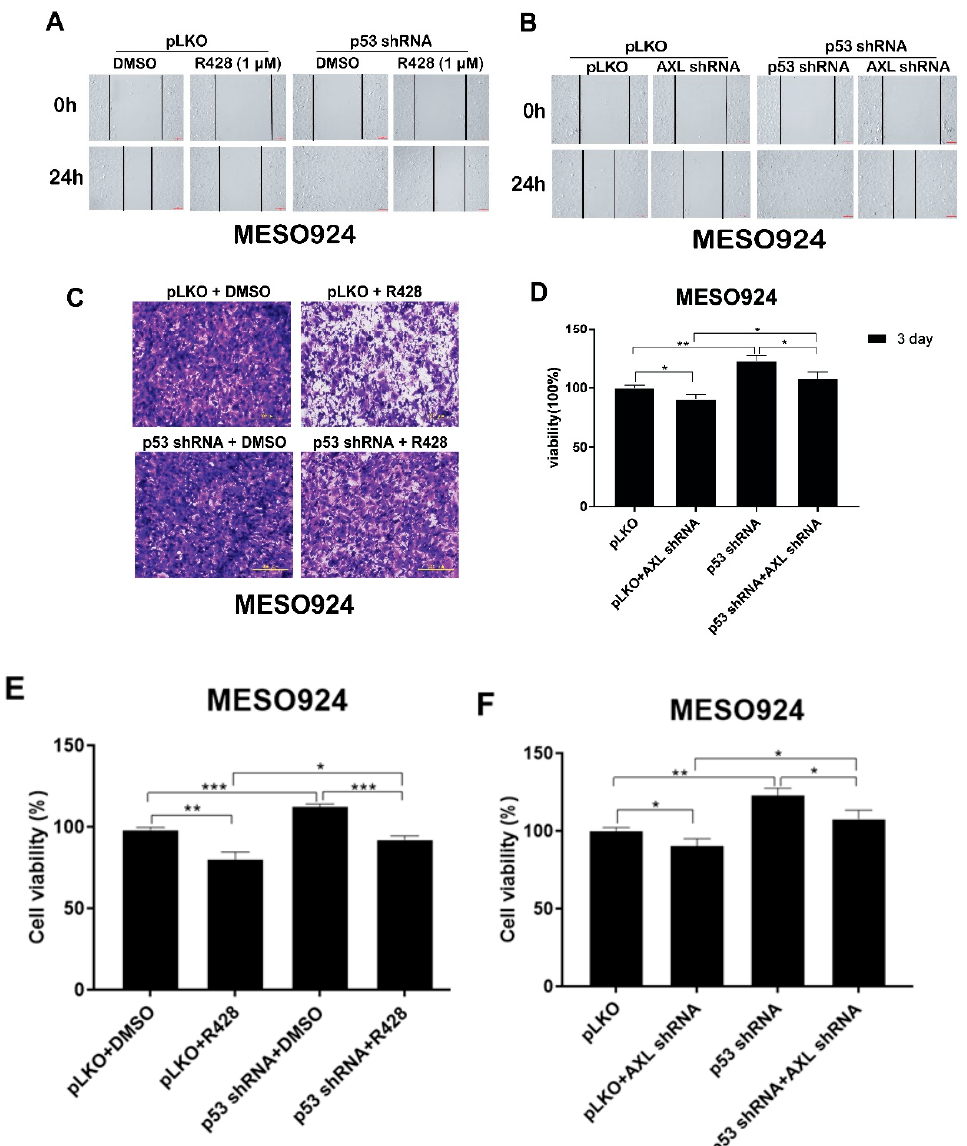
Figure 6. AXL regulates mesothelioma migration, invasiveness, and proliferation through p53. ( A , B ) R428 (1 µ M) treatment or lentiviral shRNA-mediated AXL knockdown inhibited migration of MESO924, but p53 shRNA knockdown attenuated antimigration e ff ects of R428 treatment in MESO924, as assessed by in vitro wounding assays. ( C , D ) R428 (1 µ M) treatment inhibited invasive e ff ects of MESO924 cells, but p53 shRNA knockdown attenuated anti-invasive e ff ects of R428 treatment in MESO924, as assessed by transwell matrigel assays. Data were normalized to the empty lentivirus infections or DMSO and represent the mean values ( ± s.d.) of triplicate cultures. All the assays were performed from triplicate experiments. Statistically significant di ff erences are presented as * p < 0.05, ** p < 0.01. ( E , F ) Cell viability was evaluated by MTT assay in MESO924 at day 3 after infection with lentiviral AXL shRNA, but p53 shRNA knockdown attenuated antiproliferative e ff ects of AXL silencing or AXL kinase inhibition (R428) in MESO924. Data were normalized to the empty lentivirus infections or DMSO and represent the mean values ( ± s.d.) of triplicate cultures. All the assays were performed from triplicate experiments. Statistically significant di ff erences are presented as * p < 0.05, ** p < 0.01, *** p < 0.001.